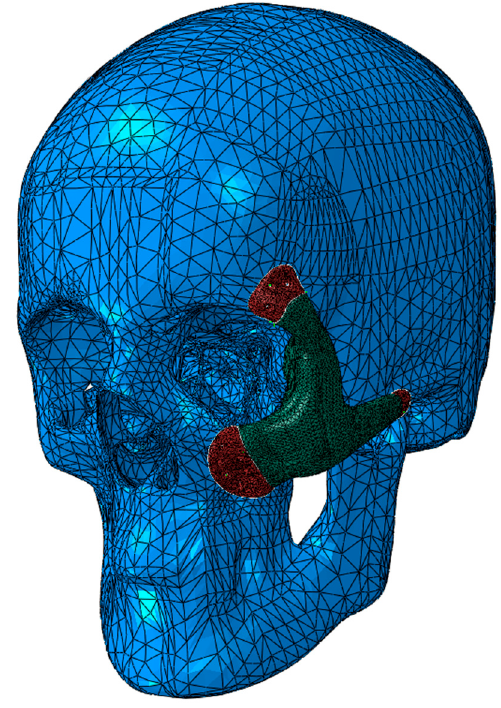
Figure 11. Finite element mesh of the skull and zygomatic implant.